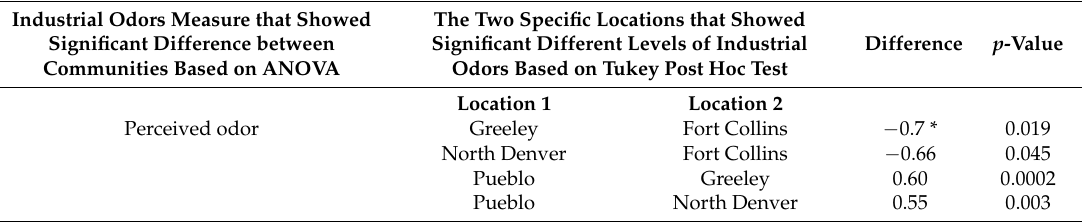
Table 8. The summary table of the Tukey Post Hoc Test results among communities’ perceived odor. Only significant results are presented. ANOVA—Analysis of